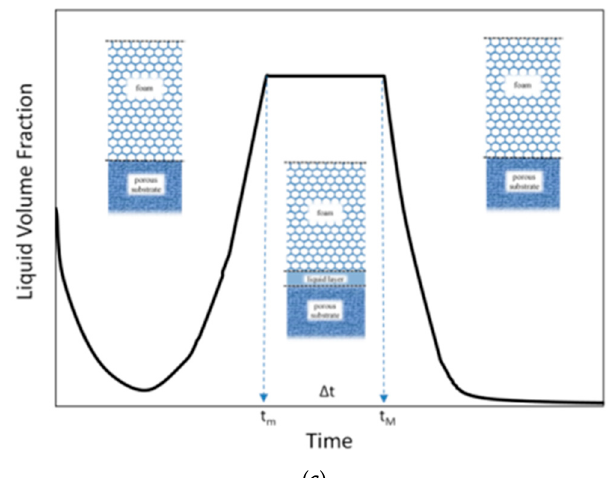
Figure 1. Schematic of the time evolution of liquid volume fraction at foam/porous substrate interface c in three different regimes of ( a ) rapid imbibition into the porous substrate: the liquid volume fraction gradually deceases; ( b ) intermediate imbibition into the porous substrate: the liquid volume fraction goes via max but this max is below critical when liquid layer starts forming; ( c ) slow imbibition into the porous substrate: at some moment t m the free liquid layer starts forming at the foam / porous substrate interface and this layer disappeared at the moment t M .